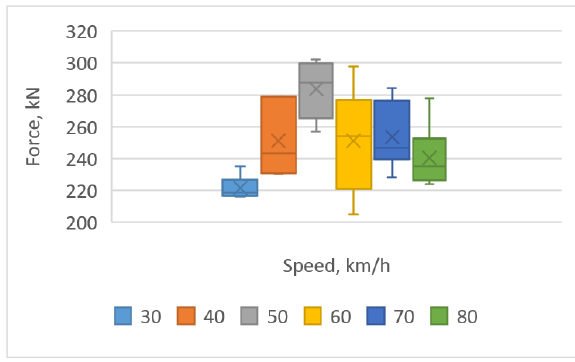
Figure 11. Maximal force values of loaded wagon. The values of the indicator Q M , calculated by the Formula (1) of maximal vertical forces of the loaded wagon are provided in Figure 12.